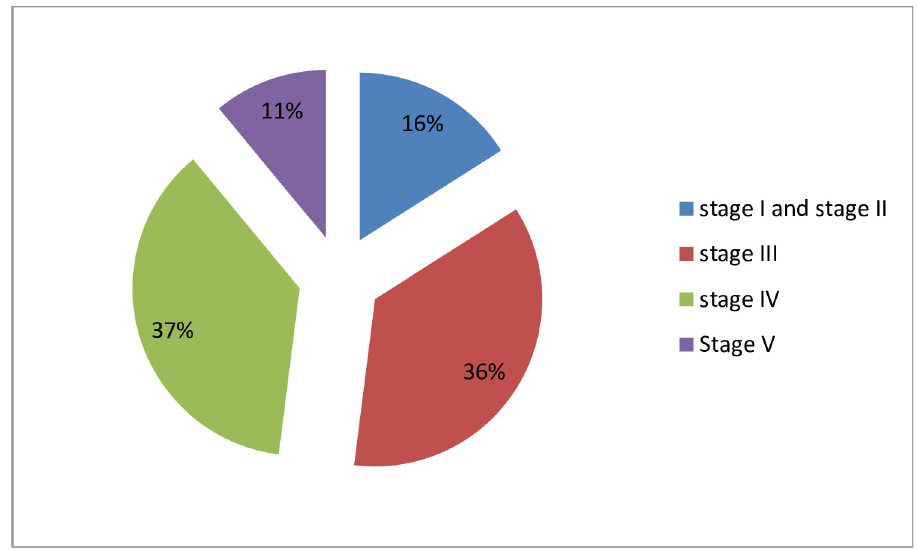
Fig 2. Stages of CKD among study participants in Saint Paulo’s and Zewditu Memorial Hospitals, 2018.